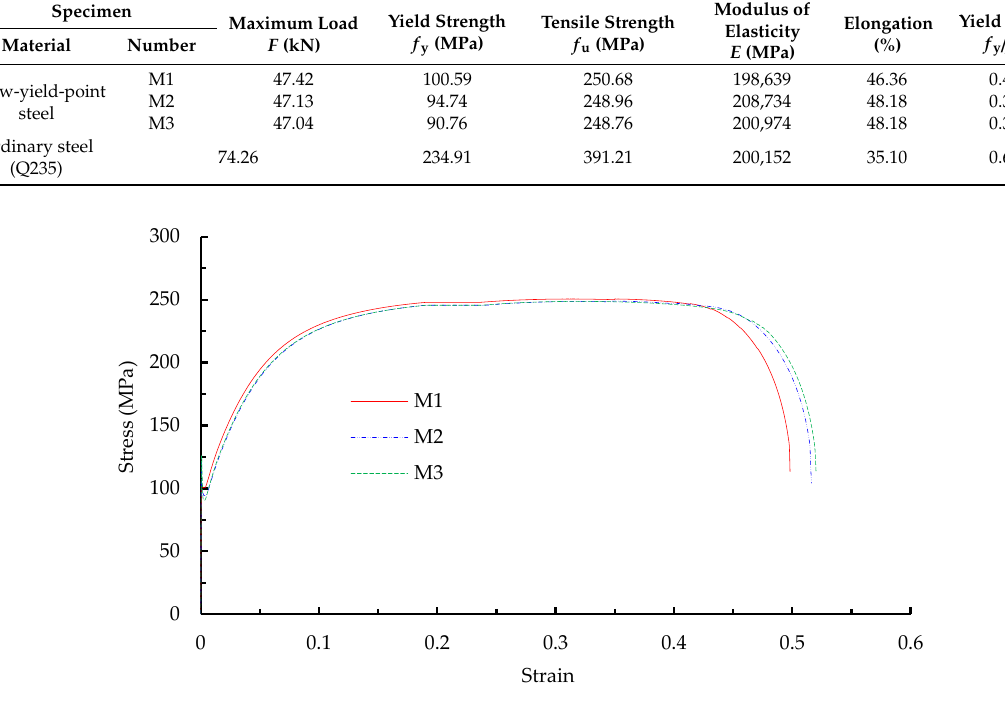
Figure 7. Fractured LYP steel coupons. Table 5. Results of the material test.